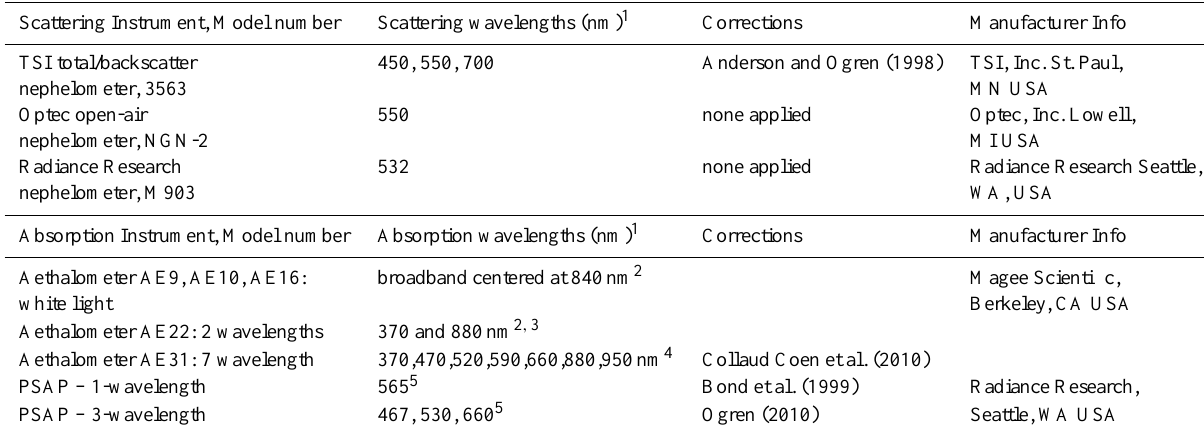
Table 2. Measurement